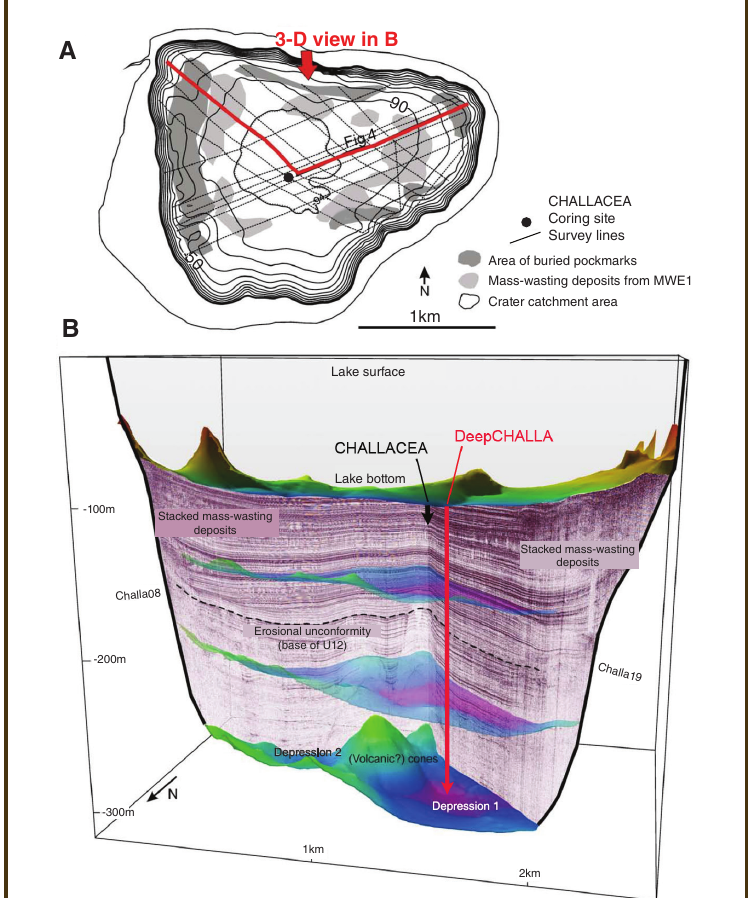
Figure 3. [A] Lake Challa bathymetry (contours in 10-m intervals) overlain with the grid of seismic survey lines completed in 2003, and location of the principal CHALLACEA coring site CH05-4P in relation to the distribution of buried pockmarks and mass-wasting deposits (MWD) linked to mass-wasting event 1 (MWE1). Also indicated (red lines) are the positions of the seismic profiles Ch0308 and Ch0319 displayed in B. [B] 3-D reconstruction of Challa sub-bottom topography based on 3.5-kHz GeoPulse seismic profiling, viewed from the north. Shown are one of the three original depocenters surrounding the central volcanic tuff cone; the gradual burial of the cones in early lake history; the depth of the 25,000-year core profile recovered by CHALLACEA; and the core recovery aimed for in DeepCHALLA (red line: to bedrock in the deepest original depocenter). Modified from Moernaut et al.